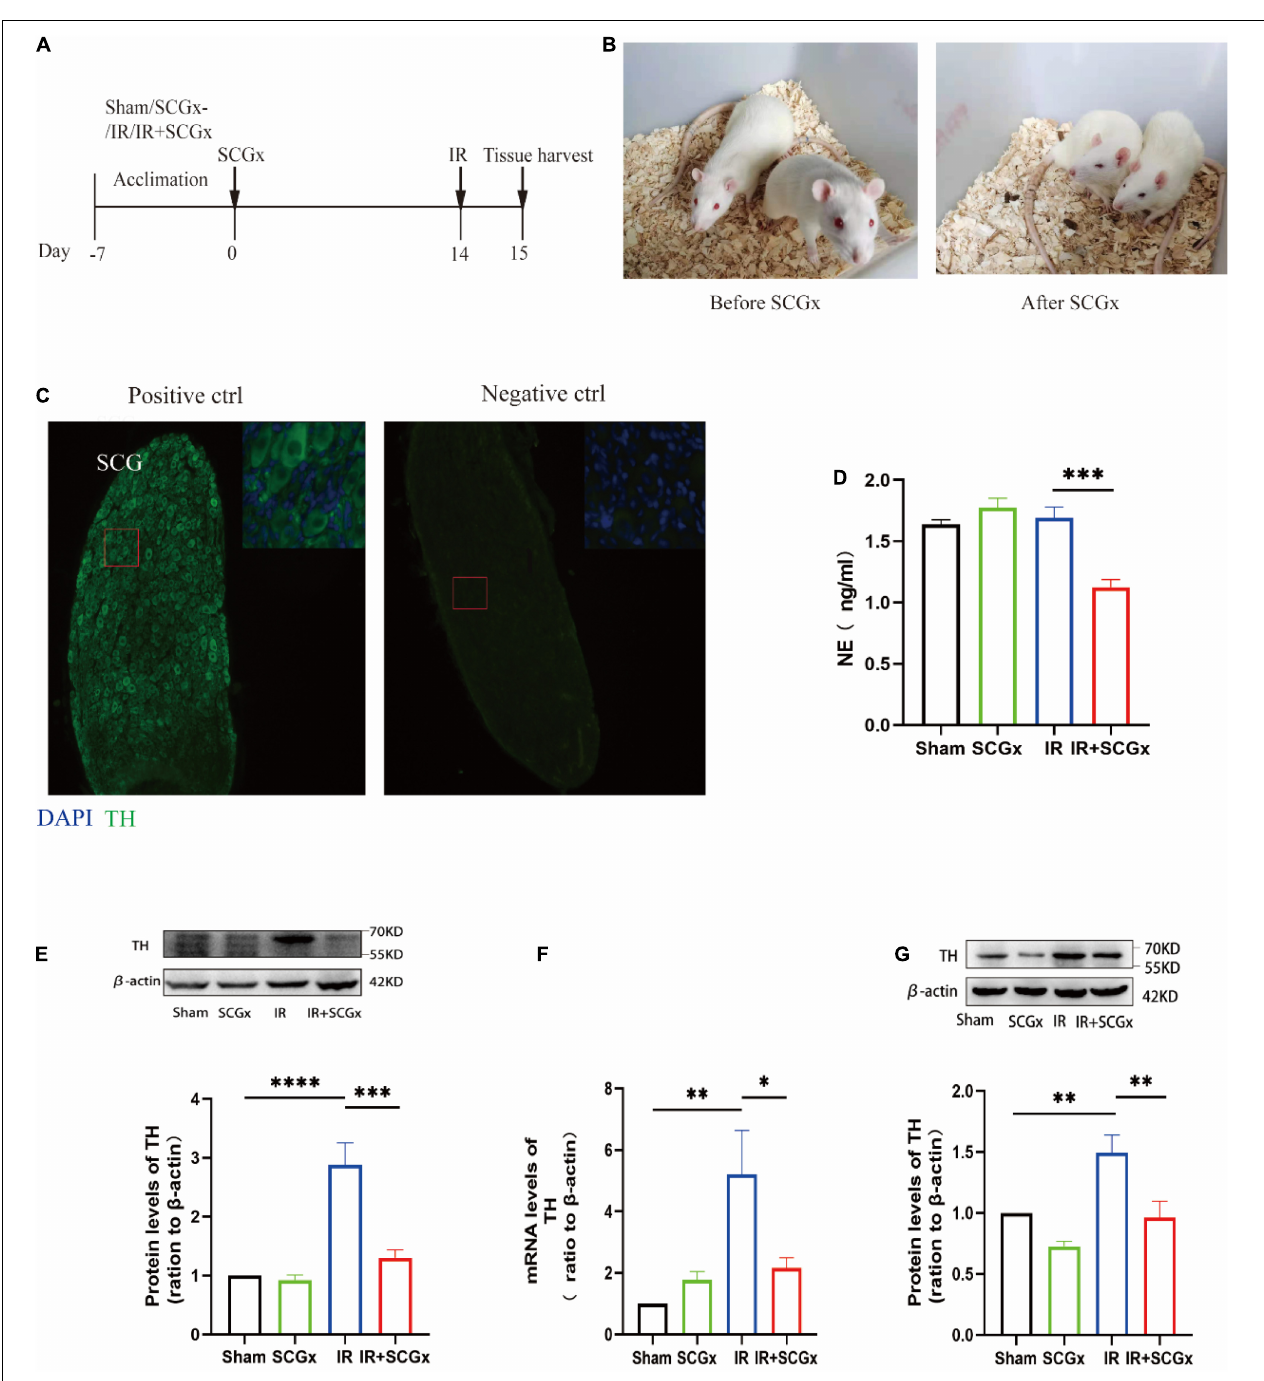
FIGURE 1 | Surgical removal of SCGs in IR rats reduced sympathetic activity. (A) Experimental scheme. The intervention group included Sham, SCGx (bilateral removal of the SCG), IR (bilateral renal ischemic for 45 min and reperfusion for 24 h), and IR + SCGx (bilateral removal of the SCG followed by renal ischemic reperfusion surgery). Tissue harvesting was performed after 24 h reperfusion. (B) Bilateral blepharoptosis after bilateral superior cervical ganglionectomy. (C) Immunofluorescence staining of surgically removed SCG. The same staining procedure served as a negative control, except that the primary antibody was omitted. Tyrosine hydroxylase (TH). Scale bar: 50 µ m. (D) The NE concentration in plasma by ELISA. (E) The protein levels of TH in the kidney. β -actin served as an internal control. (F) The mRNA levels of TH in the hypothalamus. β -actin served as an internal control. (G) The protein levels of TH in the hypothalamus. β -actin served as an internal control. * P < 0.05; ** P < 0.01; *** P < 0.001; **** P < 0.0001, each group contains at least 4 rats.